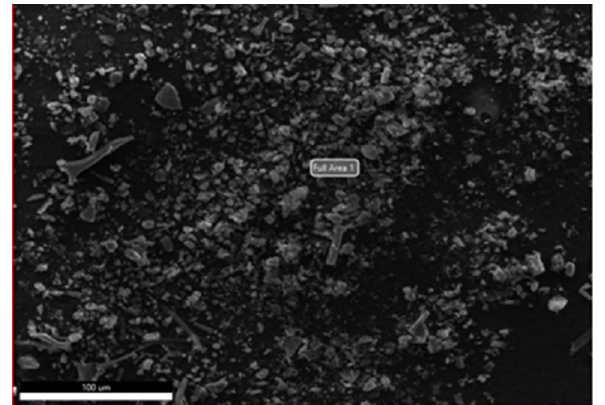
Figure 4. representative SEM of the N,S co-doped GQDs and the EDX data indicated elemental composition as 55.6% of C, 7.0% of N, 37.3 of O, and 0.1% of S by atomic weight percentage.